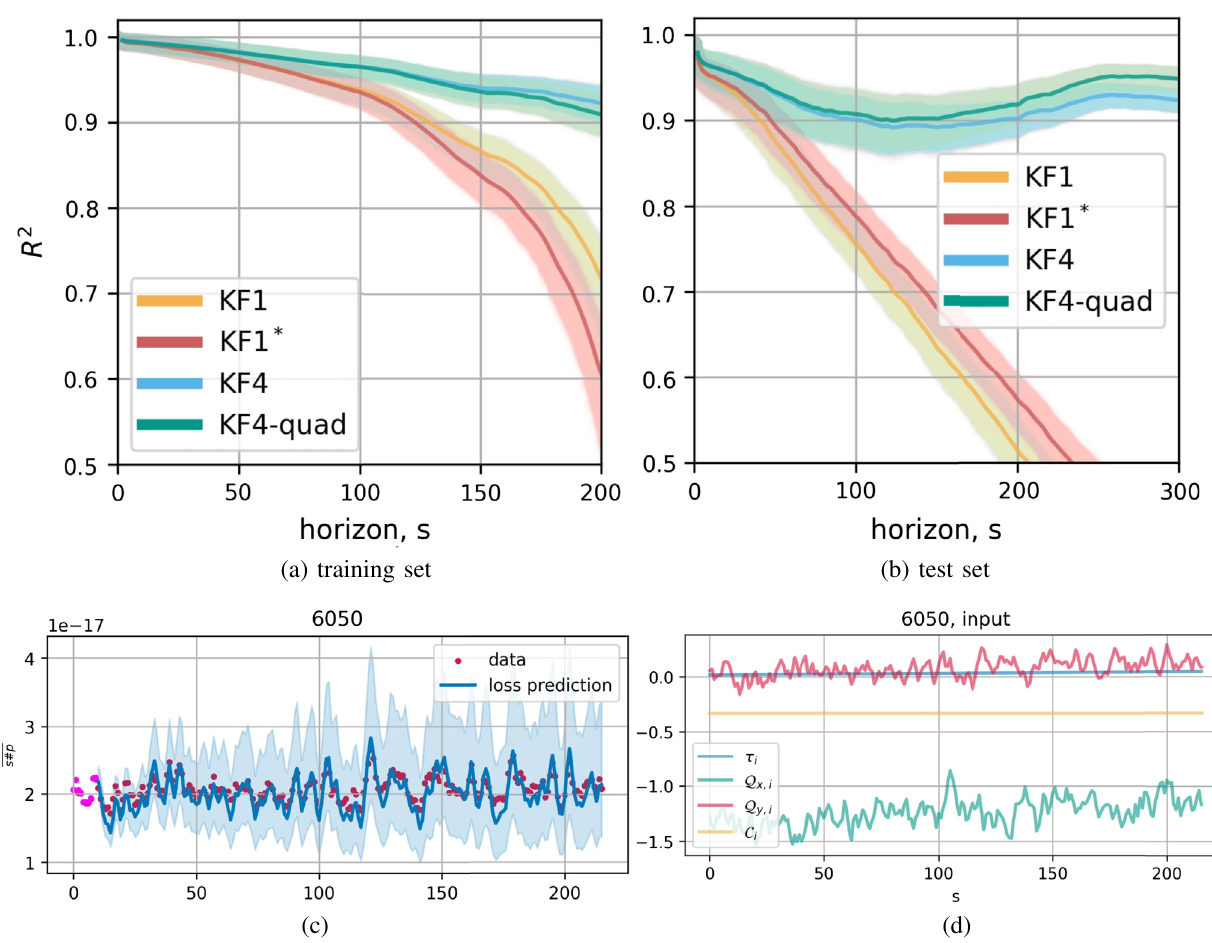
FIG. 13. (a) and (b) show the R 2 -score against different forecast horizons, where (a) is the result of the 2017 training set and (b) is the 2018 testing set. More specifically, the central lines and shaded areas are the mean and envelope of the R 2 -score of 1000 bootstrapped predictions, respectively. (c) shows the prediction result of Fill 6050 from the KF4 model with a 2 σ confidence band, and (d) is the values of the corresponding four input variables for (c). The horizons are 200 s in 2017 and 300 s in 2018 (from [74], Figs. 8 and